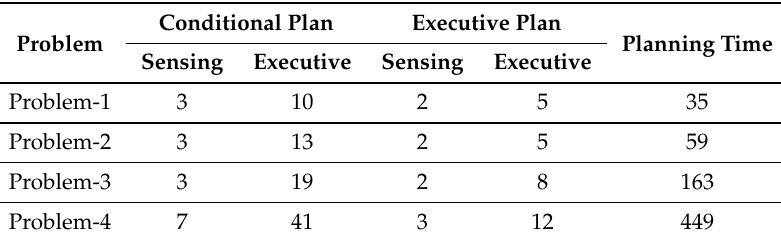
Figure 7. The manipulation example where green and red objects must be placed in the green and red regions. ( a ) shows the initial state of the problem. ( b ) shows the final state of the problem. The red object is not initially located in the robot workspace. The pink region is the place where human can transfer objects to the robot workspace. The solution can be visualized here: https://sir.upc.es/projects/ ontologies/GreenRedHuman.mp4. The solution for the case that the red object is initially located on the table is visualized here: https://sir.upc.es/projects/ontologies/TiagoRedGreenRob.mp4. Table 1. The conditional plan and executive plan length in terms of number of sensing and executive actions and planning time in seconds for the evaluated